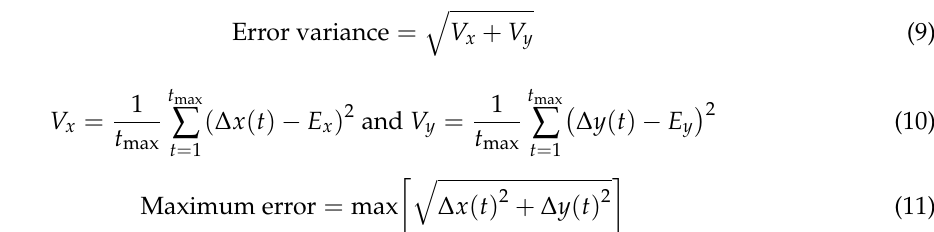
Table 3. Experimental results of the enhanced INS/Odo and INS/GPS methods for four bends.